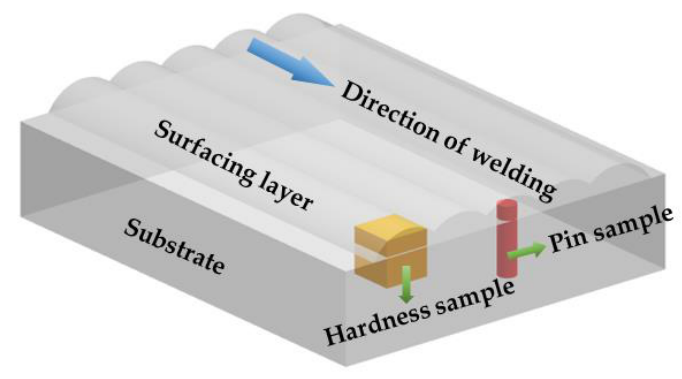
Figure 3. Schematic diagram of the pin-on-disc wear and specimen size.